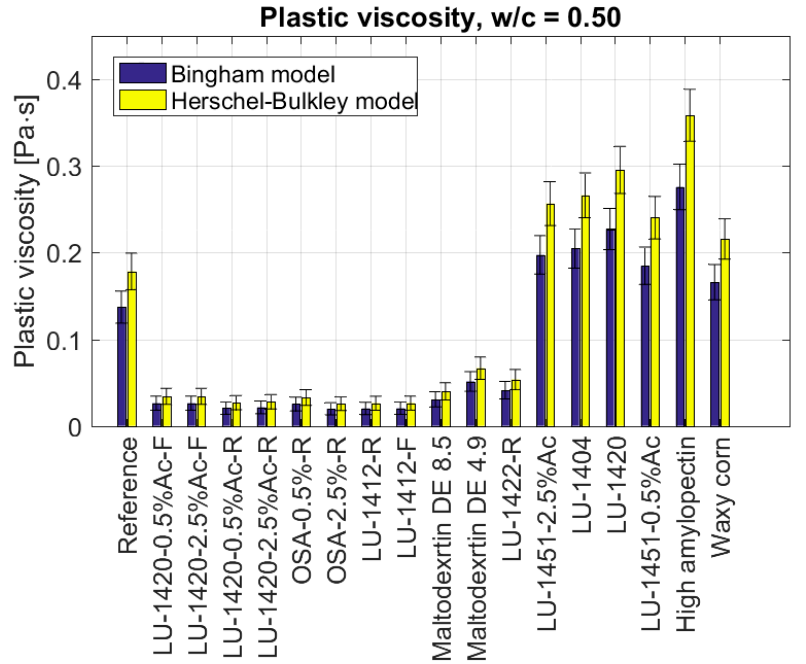
Figure 3. Plastic viscosities of cement slurries depending on the type of admixture in the form of modified starch for w/c = 0.50. modified starch for w/c = 0.50.